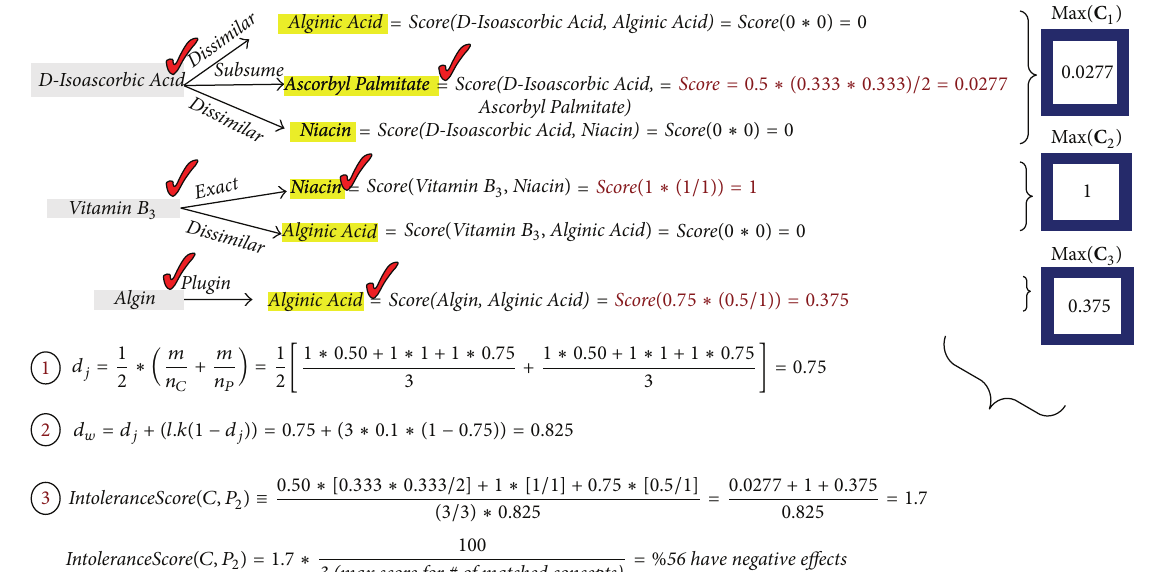
Figure 6: CME calculations of intolerance score for matching harm potential and Product 2